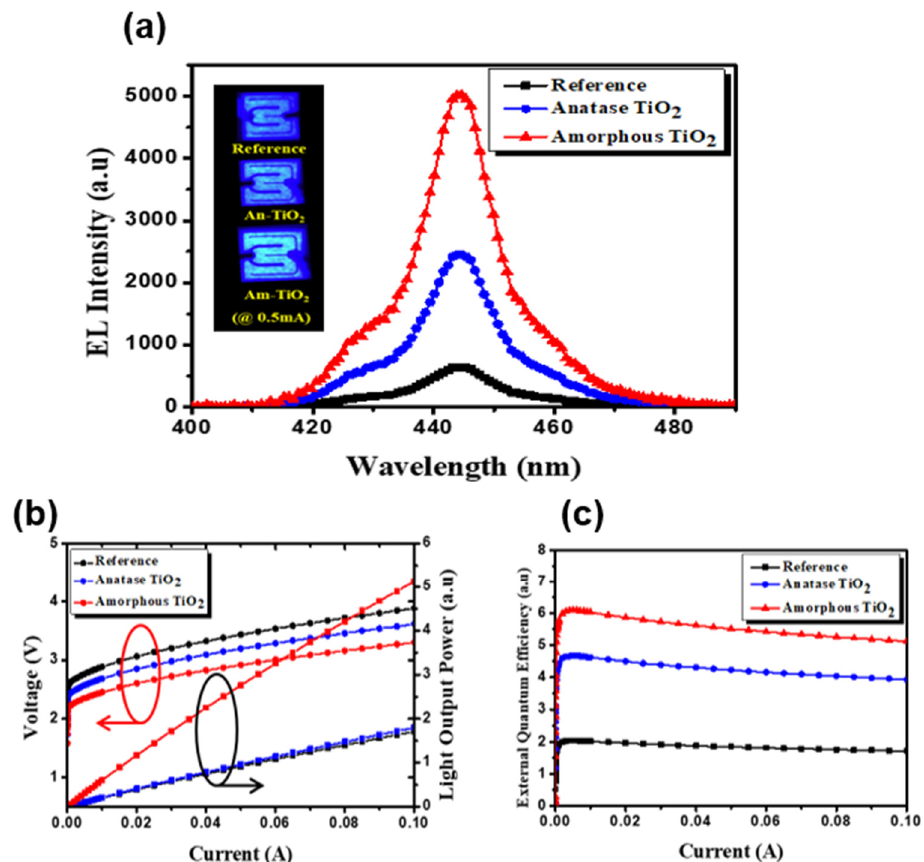
Figure 5. ( a ) EL spectra of LED chips with An- and Am-TiO 2 NS arrays with an injection current of 20 mA. Emission images of LED chips are shown in inset. ( b ) L-I-V curves and ( c ) external quantum efficiency (EQE) of LED chips with different TiO 2 NS arrays as a function of injected current (at I = 0~100 mA).